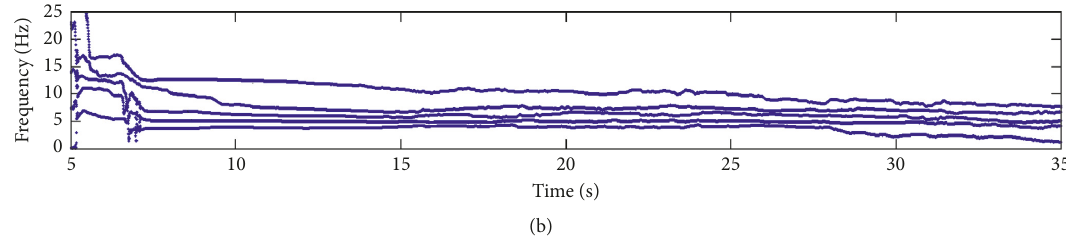
Figure 17: Time-varying modal identification results of the Pacoima dam using the San Fernando earthquake data: (a) vibration response of channel 1; (b) identification results for frequencies.